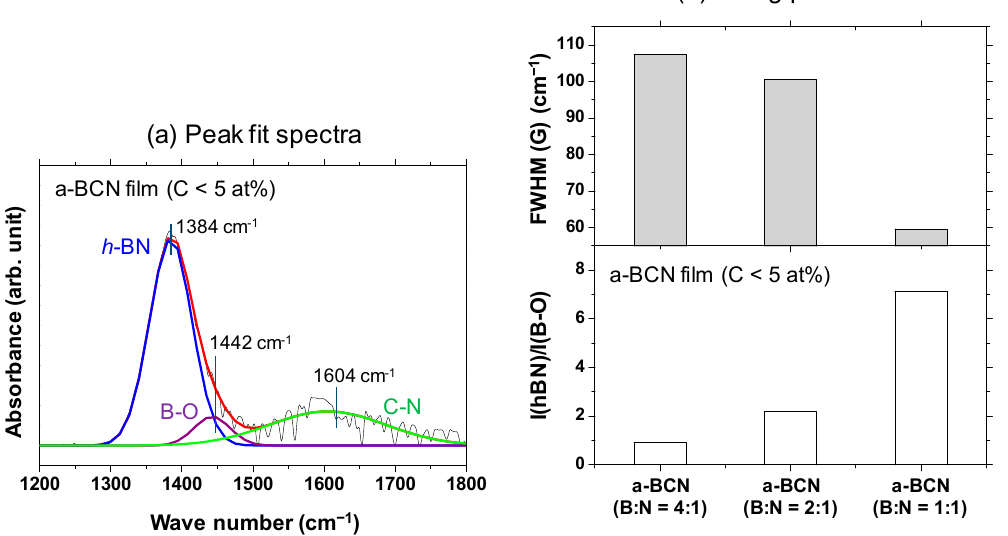
Figure 6. ( a ) Deconvoluted FTIR spectrum of the a-BCN film (C < 5 at%) with boron and nitrogen ratio of 1:1. ( b ) I(hBN)/I(B–O) and FWHM (hBN) of the a-BCN films (C < 5 at%).